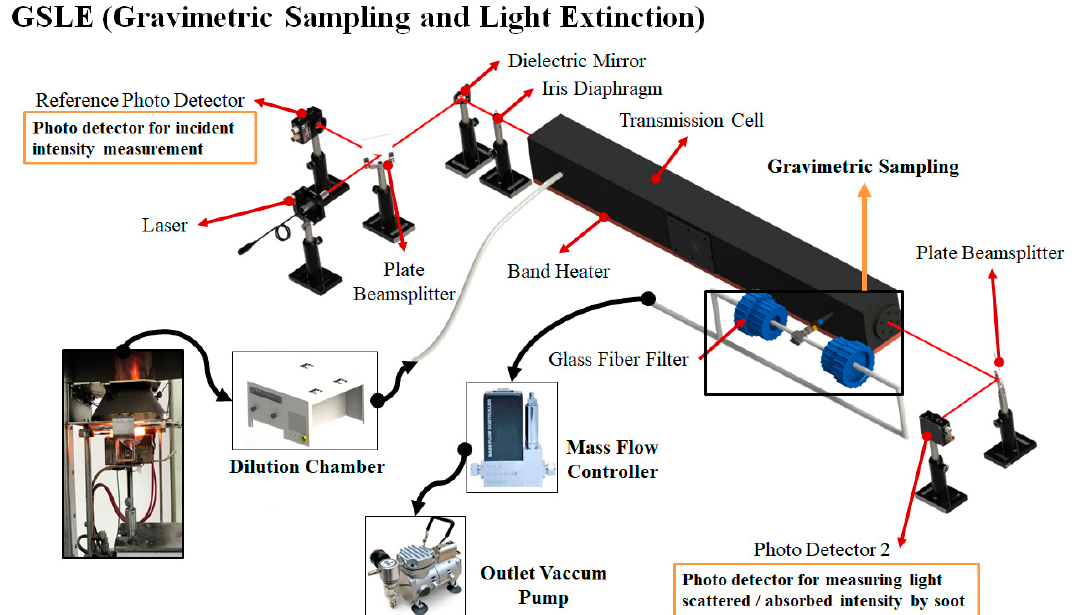
Figure 2. Schematics of experimental set-up for simultaneous gravimetric sampling and light extinction (GSLE) measurement.